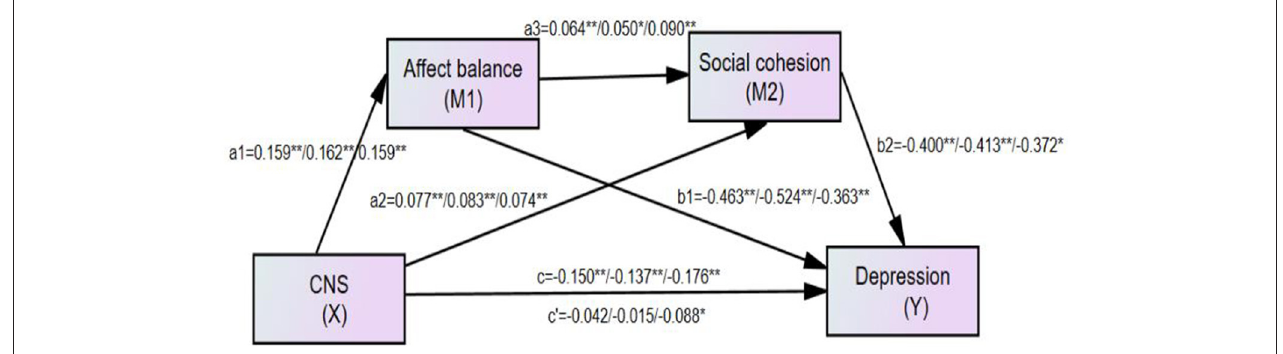
FIGURE 5 | The finalized structural model after controlling gender, age, marriage status and education level concerning the relationship between connectedness to nature and depression: affect balance and social cohesion as mediators. Left numbers, the full sample ( N = 670); Middle number, the adult sample ( N = 384); Right number, the old people sample ( N = 286); c ′ , the direct effect from connectedness to nature to depression; c , total effect from connectedness to nature to depression. **Correlation is significant at the 0.01 level. * Correlation is significant at the 0.05